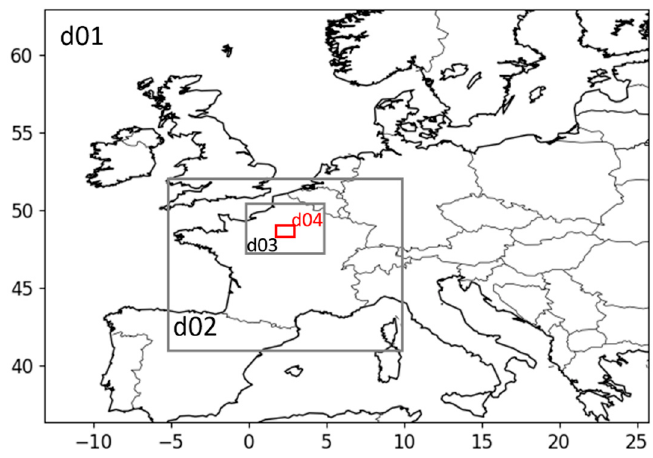
Figure 1. Four nested domains—from d01, the largest one, at a low resolution to d04, the finest one, at a high resolution.